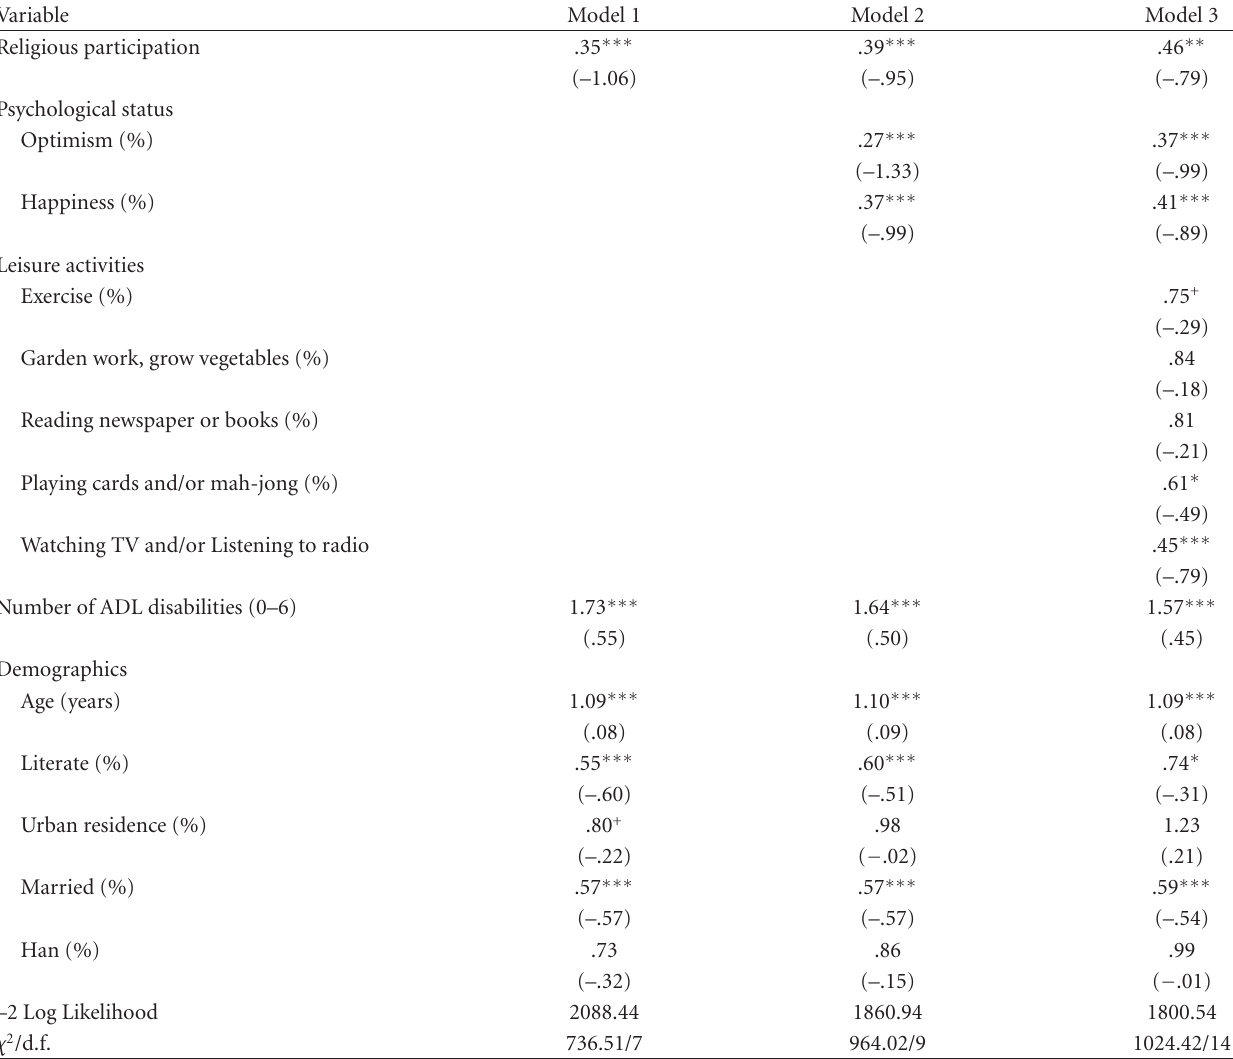
Table 3: Estimated Odds Ratios for religious participation, demographics, and mediators, on cognitive impairment for Men (Logistic Regression Estimate: Oldest-Old Chinese